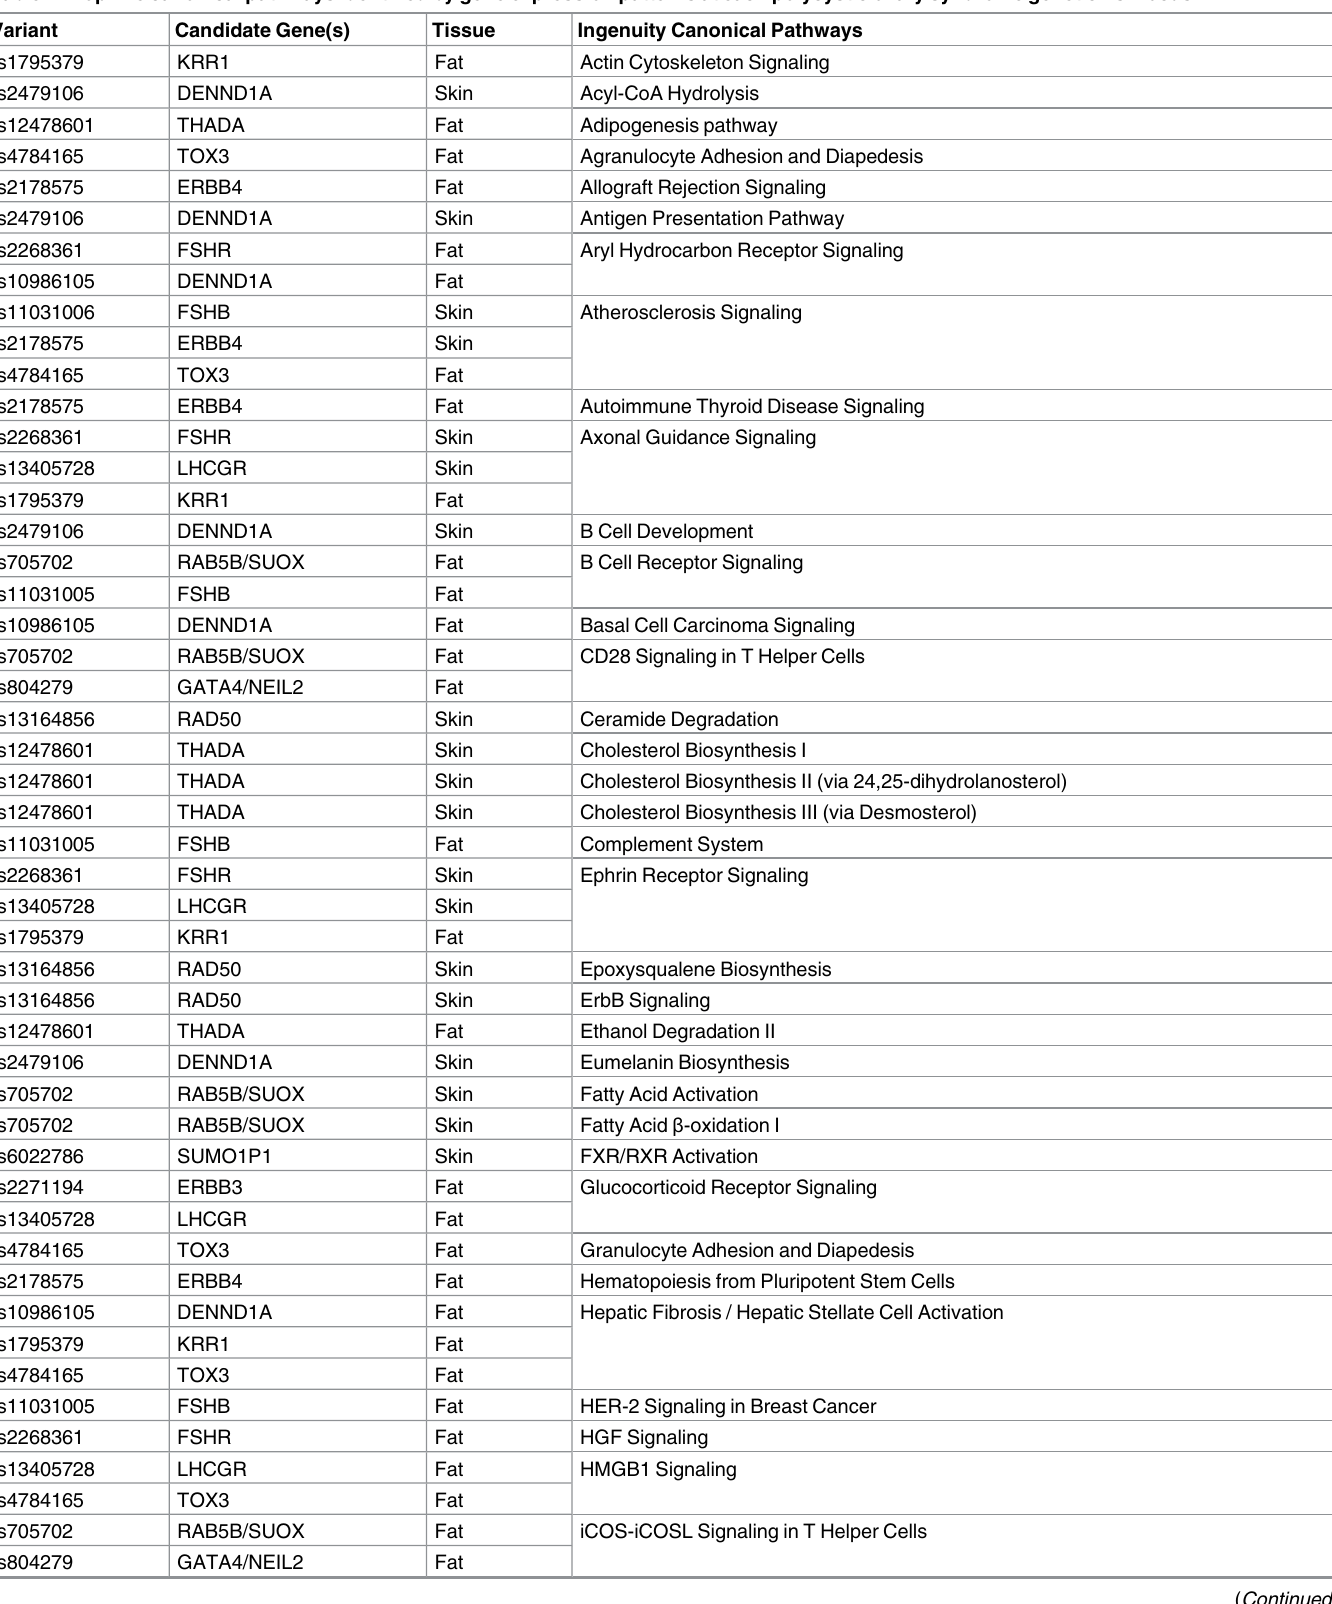
Table 2. Top five canonical pathways identified by gene expression patterns at each polycystic ovary syndrome genetic risk locus.